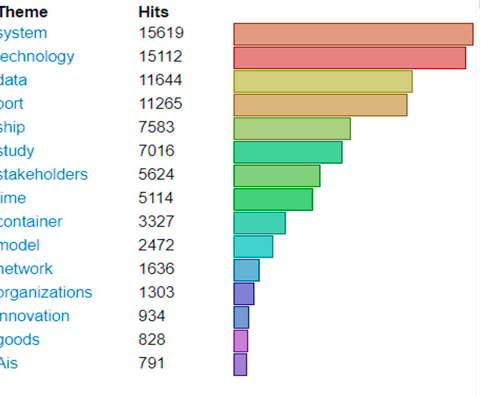
Figure 6. Identified themes and their distribution in the analyzed publications.